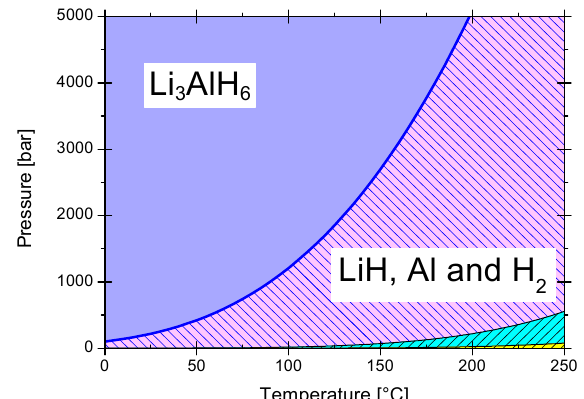
Figure 6. Phase diagram of LiH / Al / H 2 and Li 3 AlH 6 . The blue line represents the equilibrium. Data adapted from reference [86]: ln ( p ) = − 0.22 + 13.89 ; where (in the original formula) p is in atm, T in Kelvin and ∆ H R = 0.22 eV. For visual reference (bottom and right) the equilibrium of Ti-doped Na 3 AlH 6 (blue zone) and NaH + Al (yellow zone) phases were included [88].